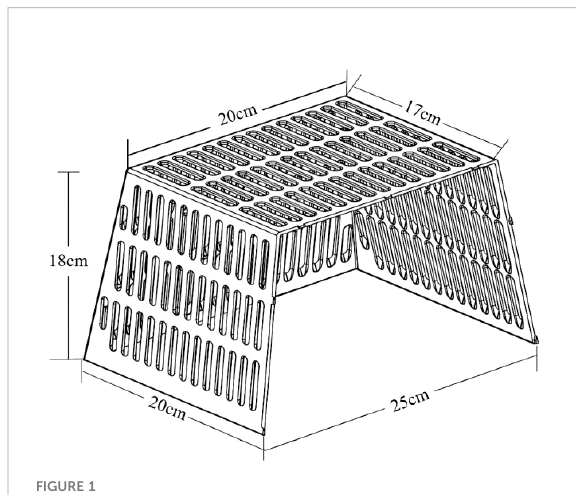
FIGURE 1 Shape and speci fi cation of the shelter of swimming crab used in this